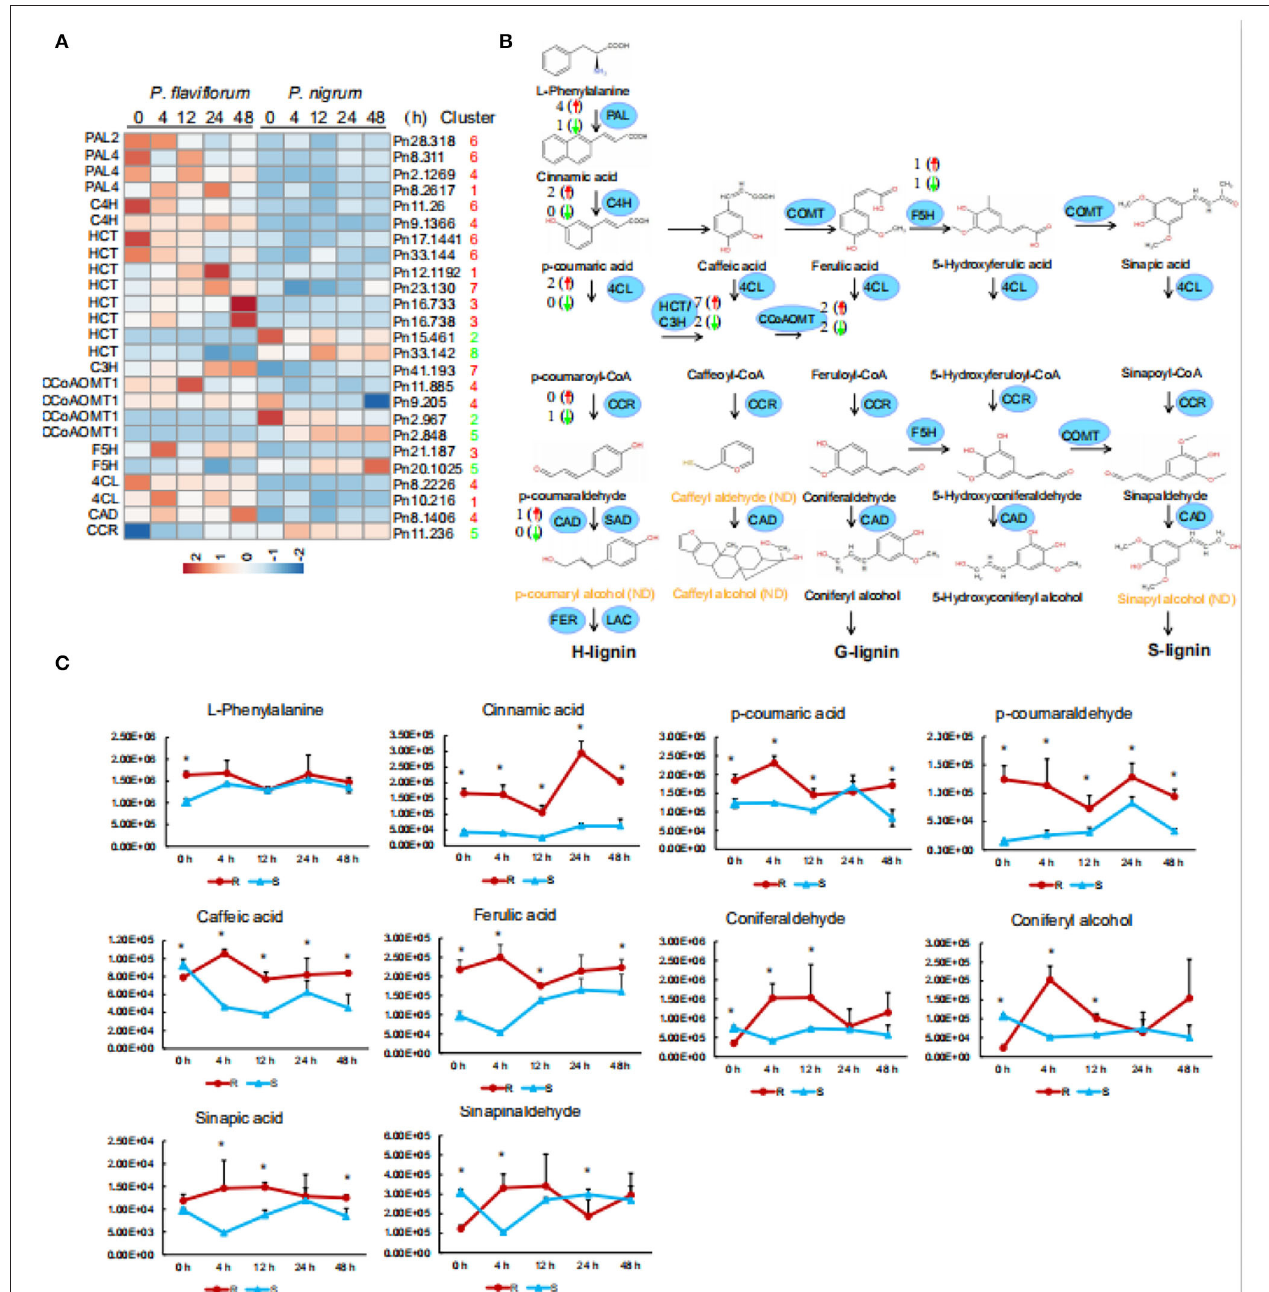
FIGURE 4 | Enriched accumulation of lignin precursors in resistant Piper ( P. flaviflorum ). (A) Heatmap of all differentially expressed genes in the lignin biosynthesis pathway. (B) Diagram of the lignin biosynthesis pathway, annotated with differentially expressed genes. Red arrows indicate higher and green arrows lower expression in resistant Piper ; numbers indicate the number of putative genes with differential expression. ND, not detected. (C) Time-course-dependent accumulation of lignin precursors in the LC-MS/MS data of root samples at 0, 4, 12, 24, and 48 hpi. R: resistant Piper ( P. flaviflorum ); S: susceptible Piper ( P. nigrum ).